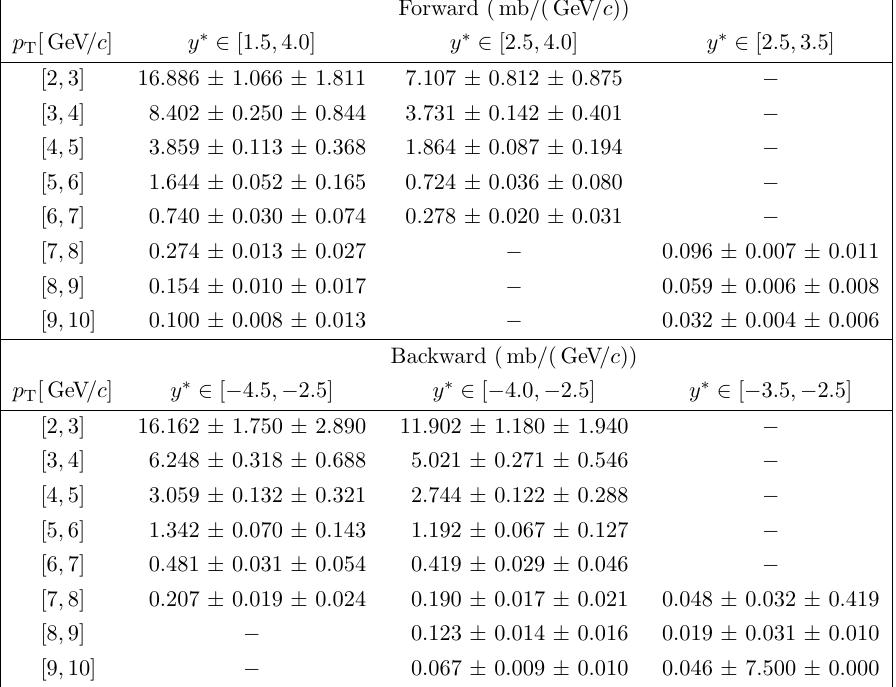
Table 2 . Measured di(cid:11)erential cross-section (in mb = ( GeV =c )) of prompt (cid:3) + of p T in p Pb forward and backward data in di(cid:11)erent rapidity regions. The right column shows the results for p T > 7 GeV =c and 2 : 5 < j y (cid:3) j < 3 : 5, which are used to compute the R FB values at p T > 7 GeV =c . The (cid:12)rst uncertainties are statistical and the second are systematic.